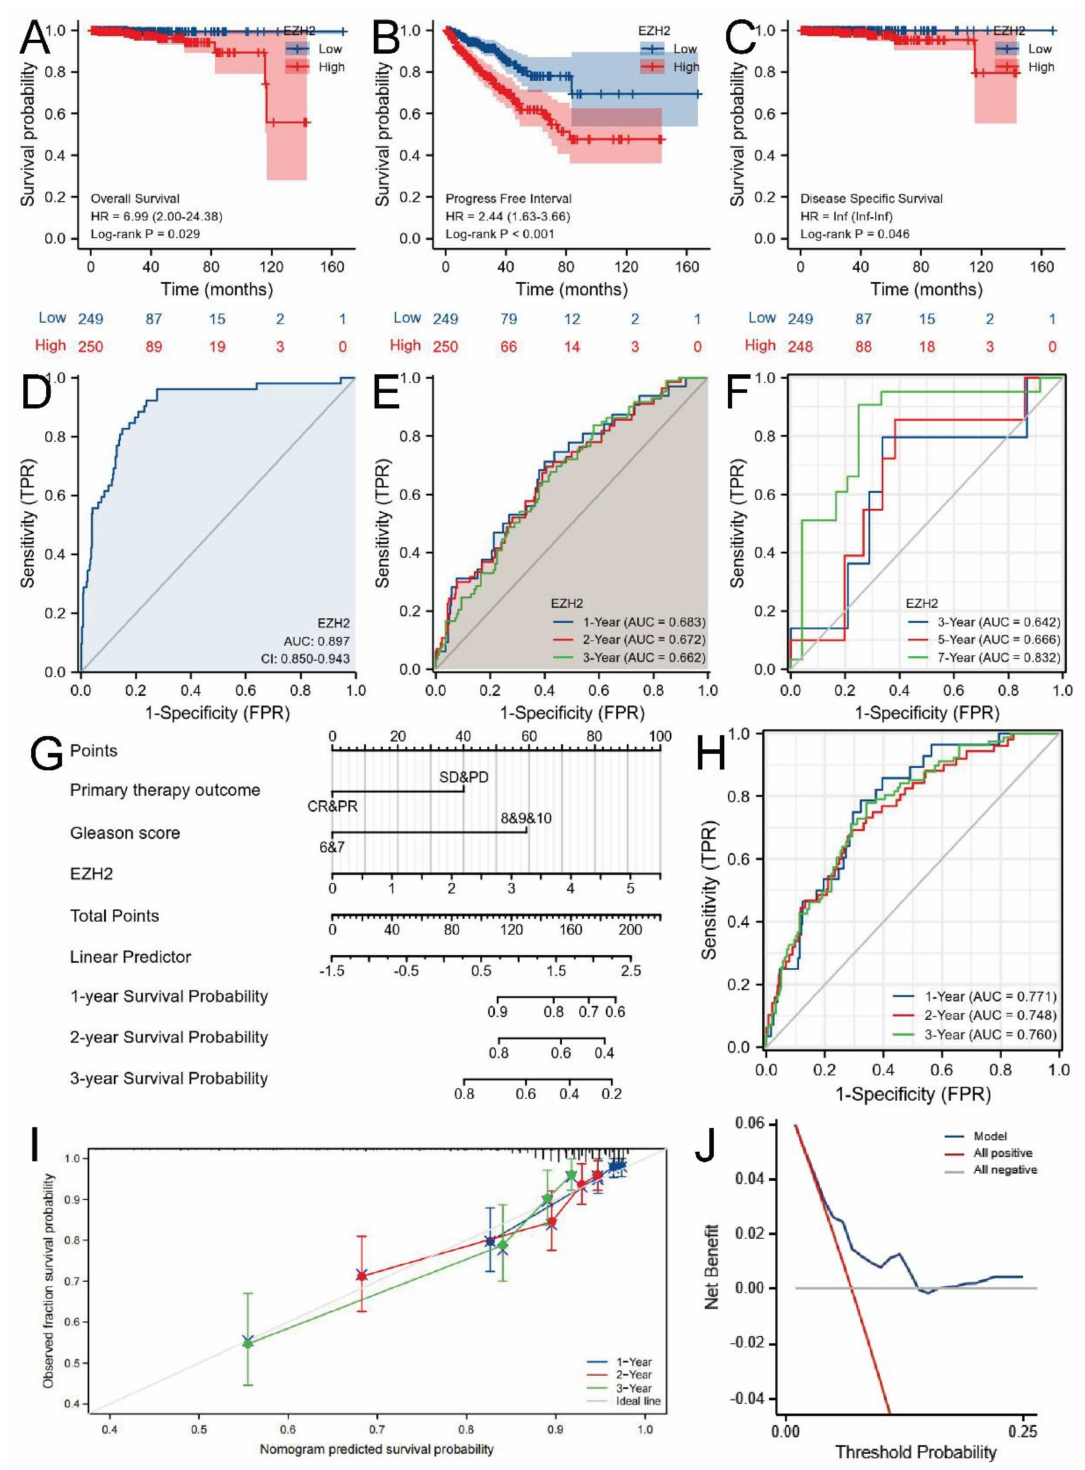
Figure 4. Prognostic value of EZH2 in PCa. The survival curves of EZH2 high- and low-expression groups in ( A ) OS, ( B ) PFS, and ( C ) DSS. ( D ) Diagnostic ROC curve of EZH2. Time-dependent survival ROC curves of ( E ) 1-, 2-, 3-year PFS and ( F ) 3-, 5-, 7-year OS. ( G ) Nomogram and ( H ) ROC curves of 1-, 2-, and 3-year PFS probabilities. ( I ) 1-, 2-, and 3-year PFS calibration curves. ( J ) DCA of prognostic